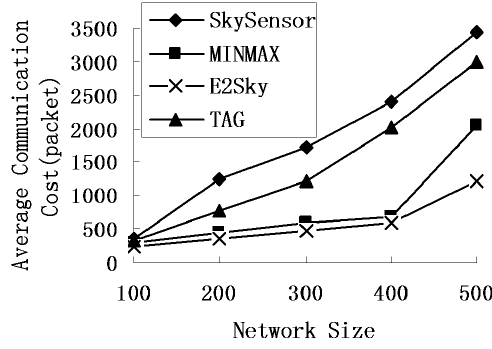
Figure 4. Average communications cost under different network sizes.